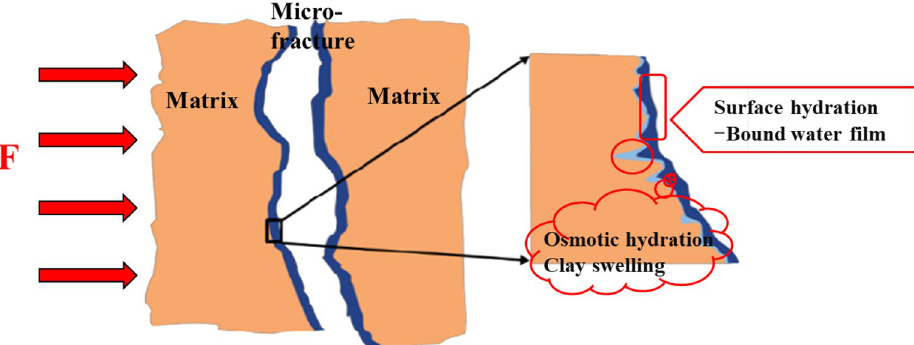
Figure 2. Schematic diagram of water–rock interaction (reservoir scale).